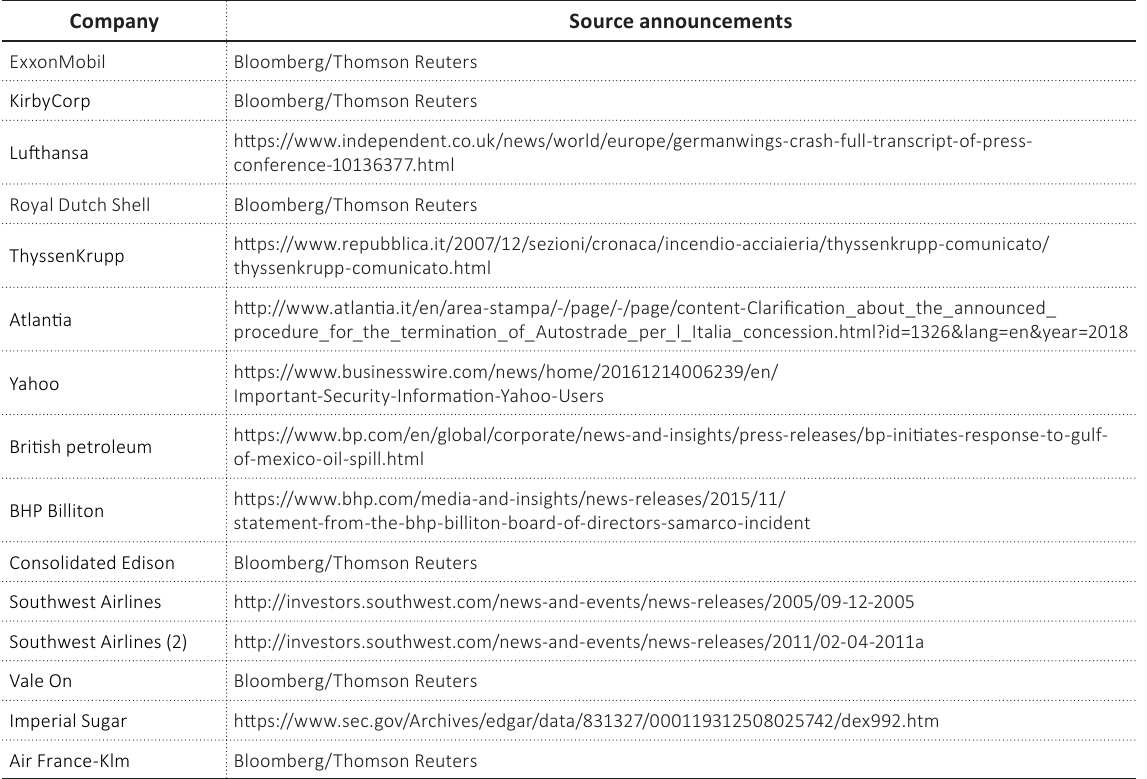
Table A2. Incidents. Shock event announcement